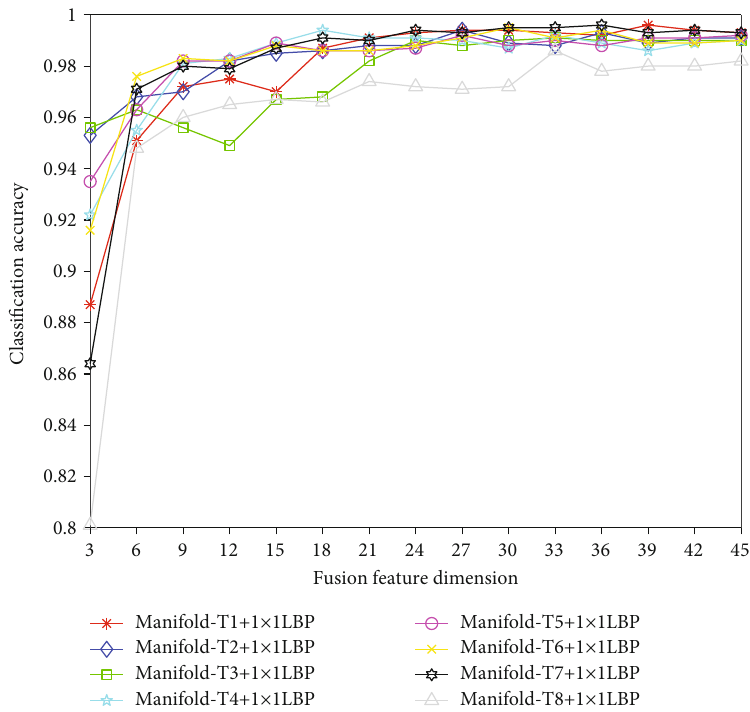
Figure 19: Variation trend of classi fi cation accuracy with the change of fusion feature